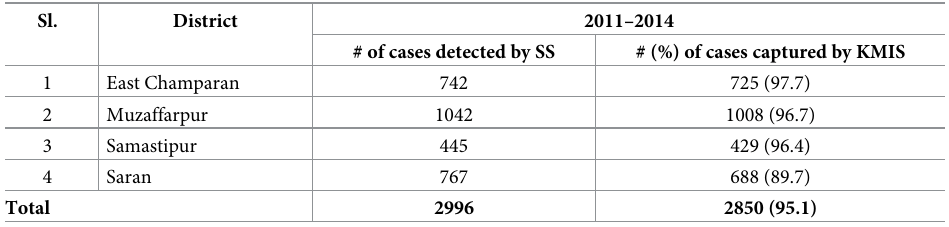
Table 5. Concordance between sentinel surveillance and KMIS data by district.